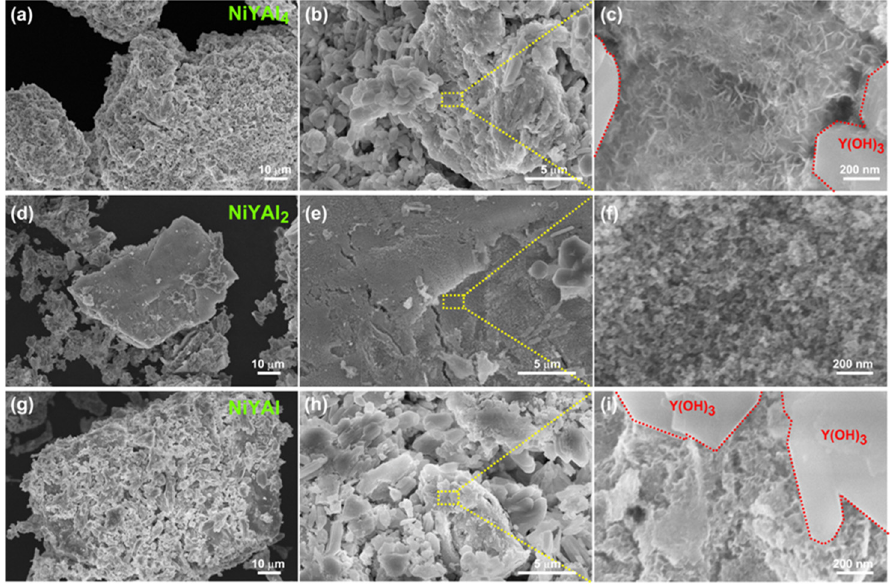
Figure 3. SEM images of the nanoporous catalysts derived from ( a – c ) NiYAl 4 , ( d – f ) NiYAl 2 , and ( g – i ) NiYAl intermetallic precursors.